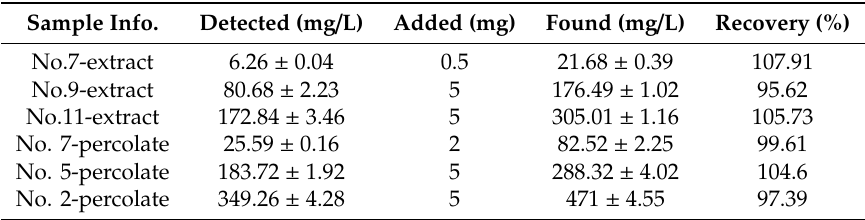
Table 3. The recovery rate of GCE / AuNPs / PPy(NO 3 − ) ISE. Sample